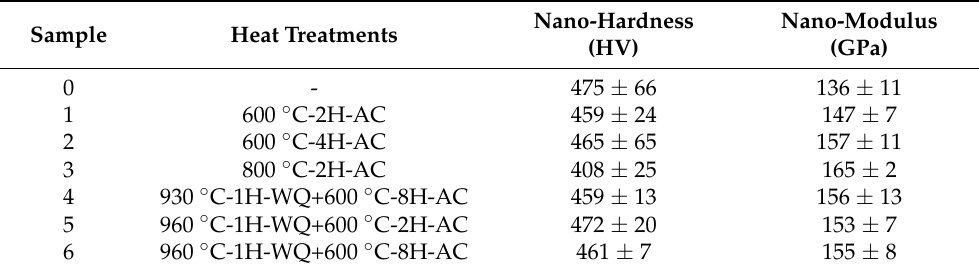
Table 4. Nanoindentation hardness and modulus of elasticity of SLM TC4 under different heat treatments.